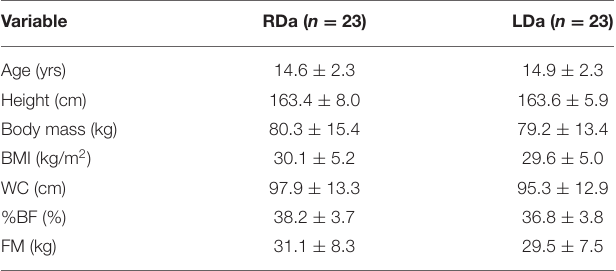
TABLE 1 | Baseline descriptive characteristics for the participants in the RDa and LDa groups.